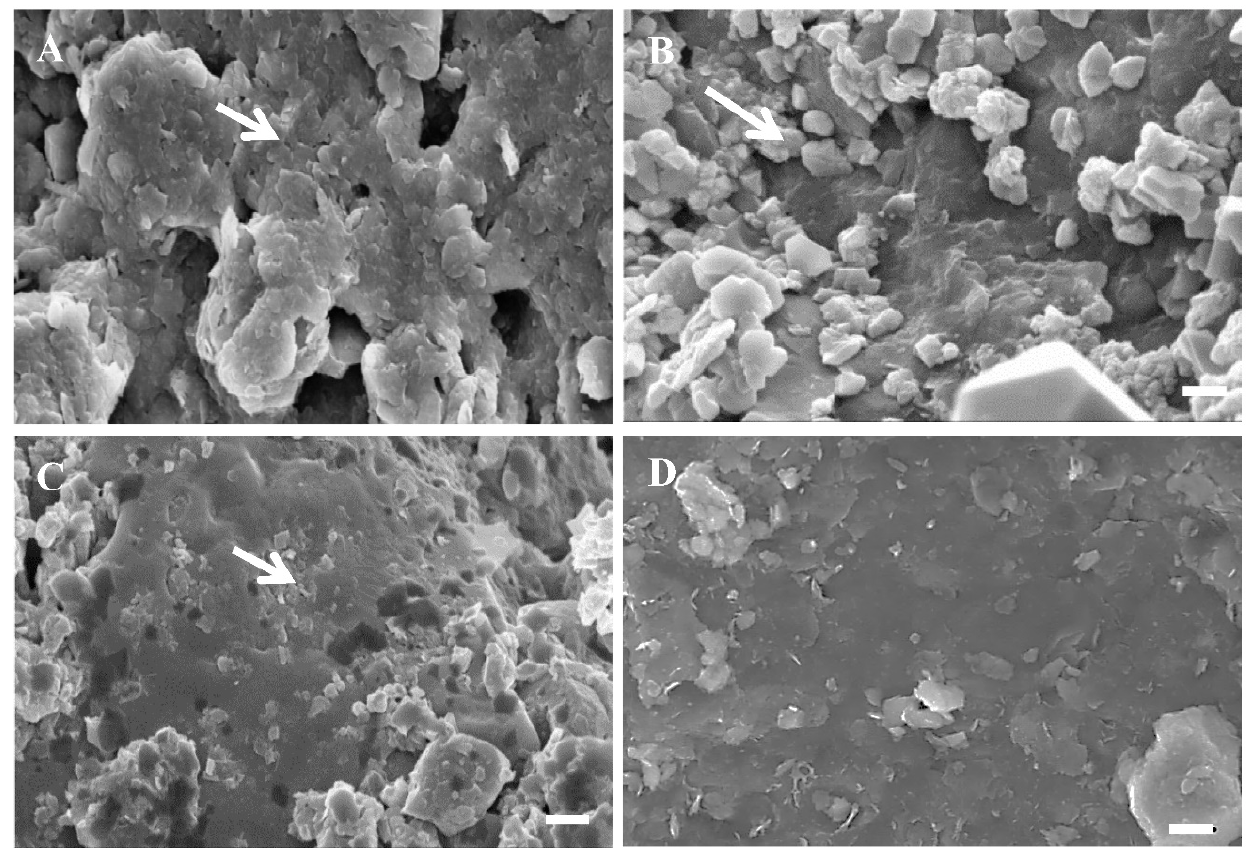
Figure 3. Bacterial biofilm on the surface of shale rock enriched in: ( A ) kerogen III, ( B ) kerogen IV.1, and ( C ) kerogen IV.2. ( D ) The surface of shale rock enriched in kerogen II. Arrows—cell-like structures detected on shales (SEM images), bar—2 µm.